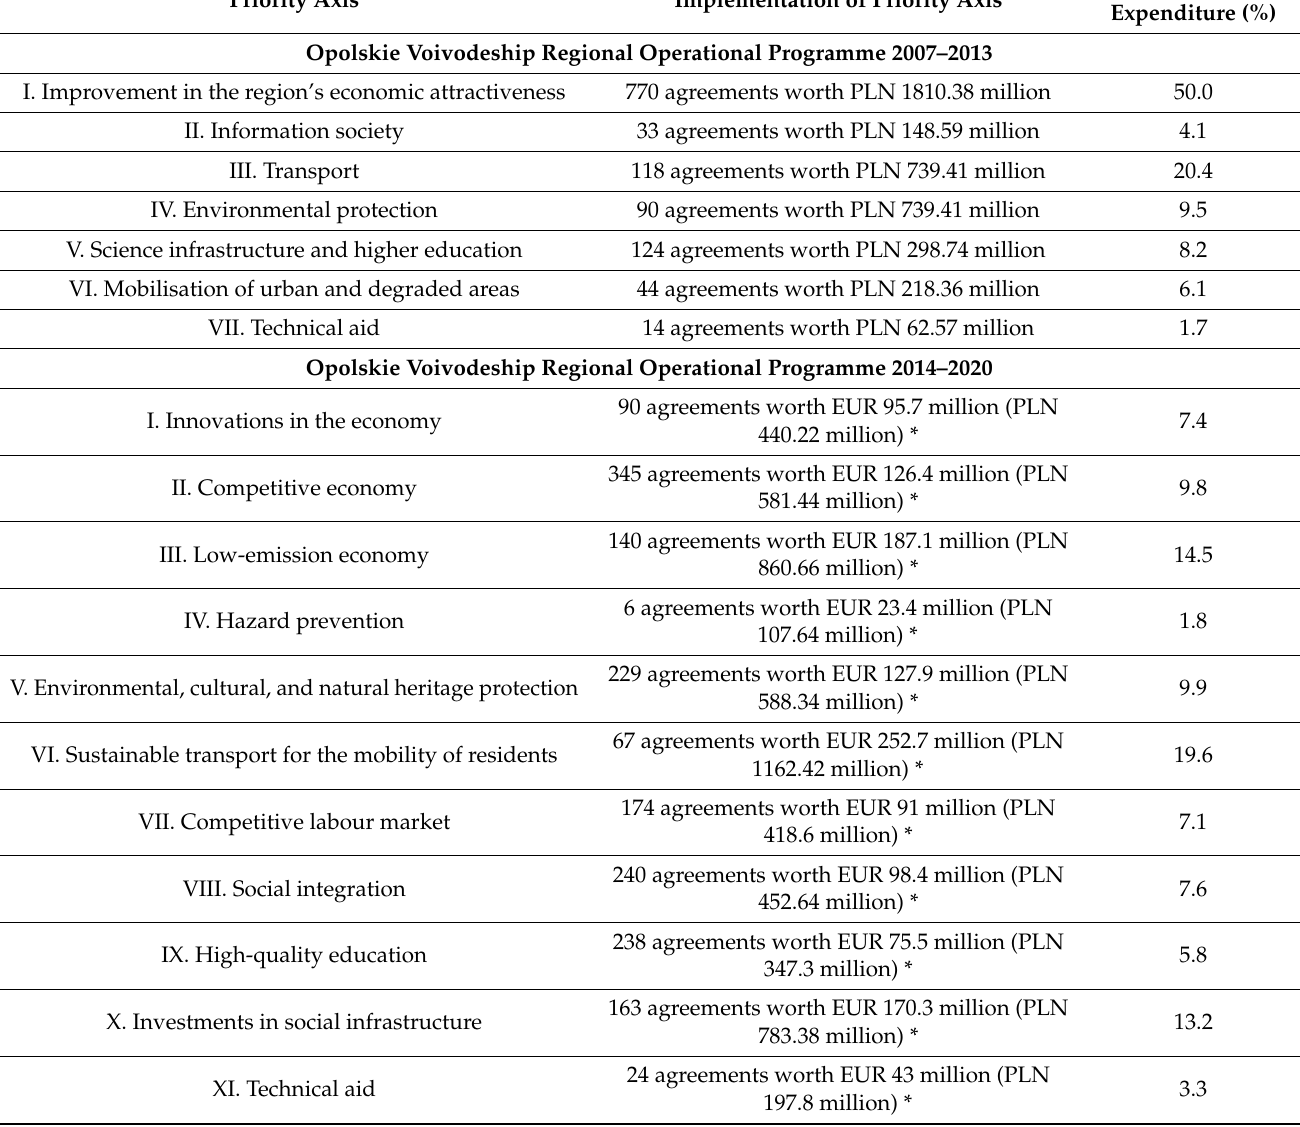
Table 5. Implementation of priority axes as part of the ROP 2007–2013 (status as of 2014) and ROP 2014–2020 (status as of